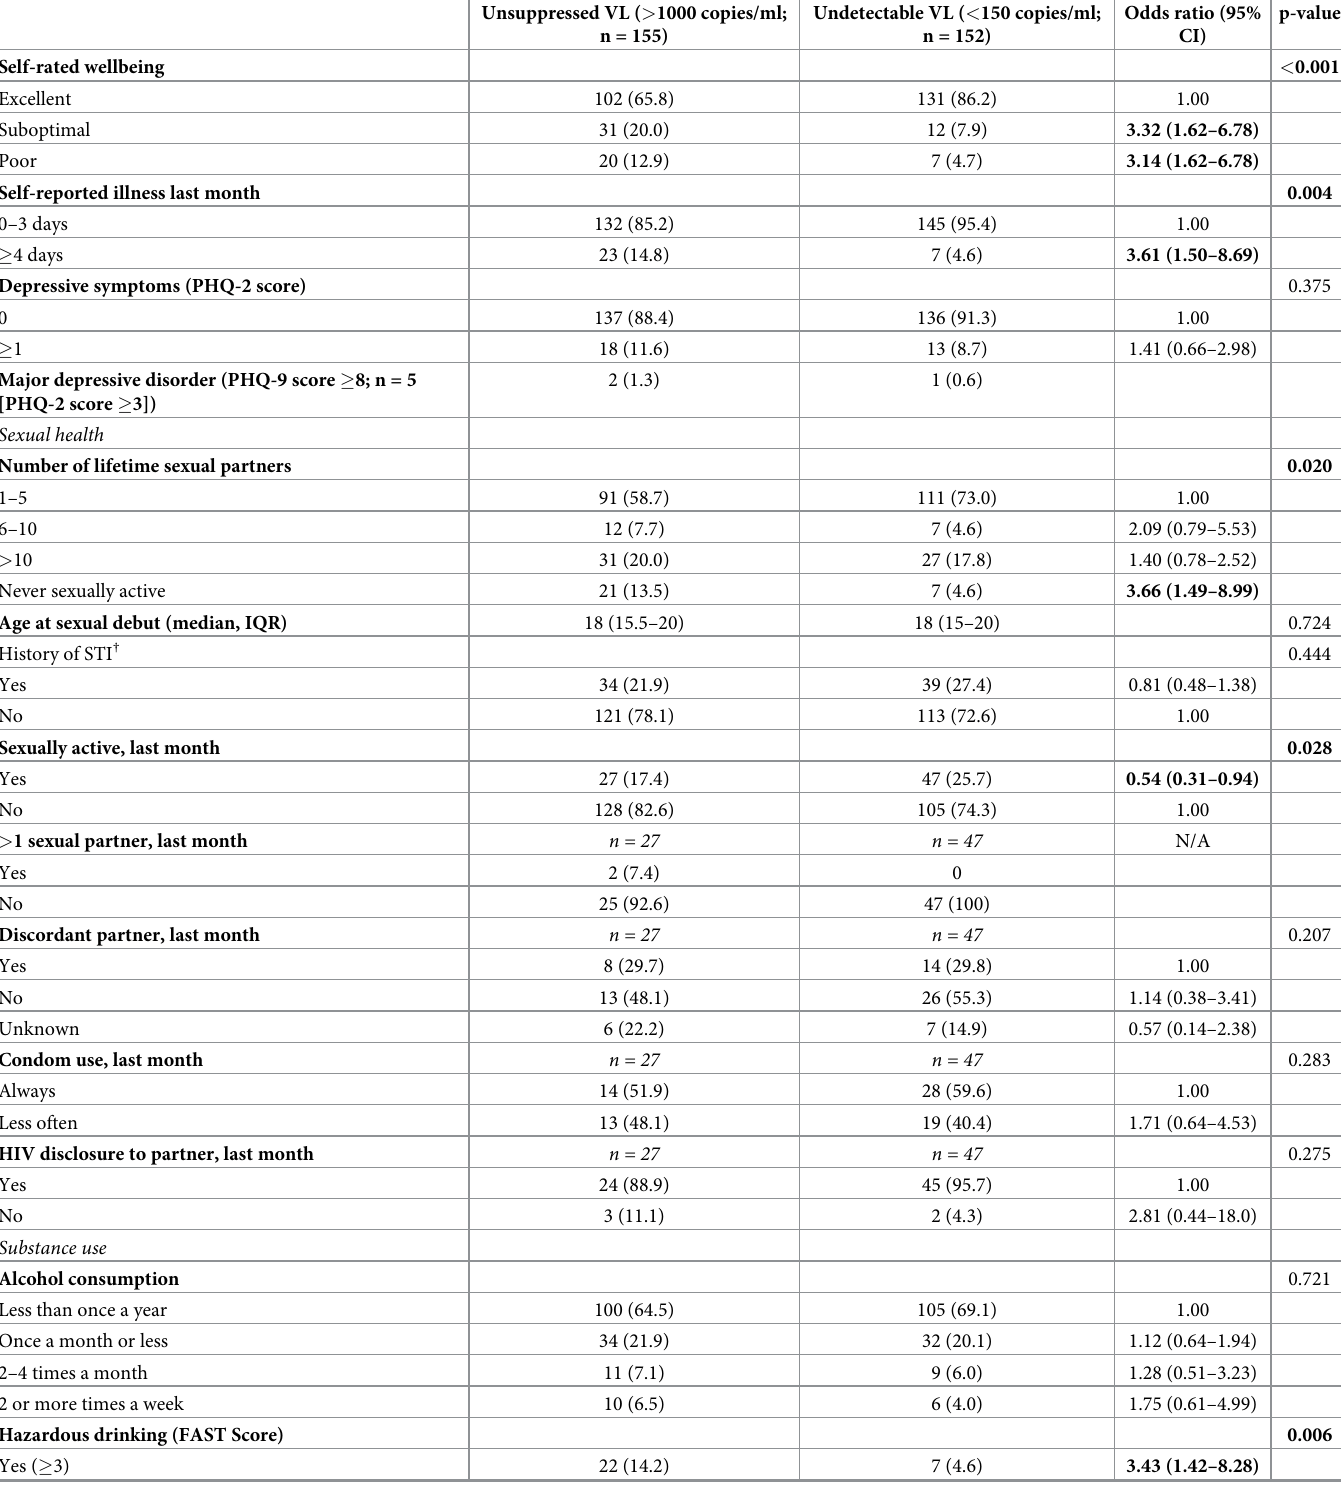
Table 3. Comparison of physical, mental and sexual health, and substance use of study participants on ART with lack of virological suppression and with undetect- able viral